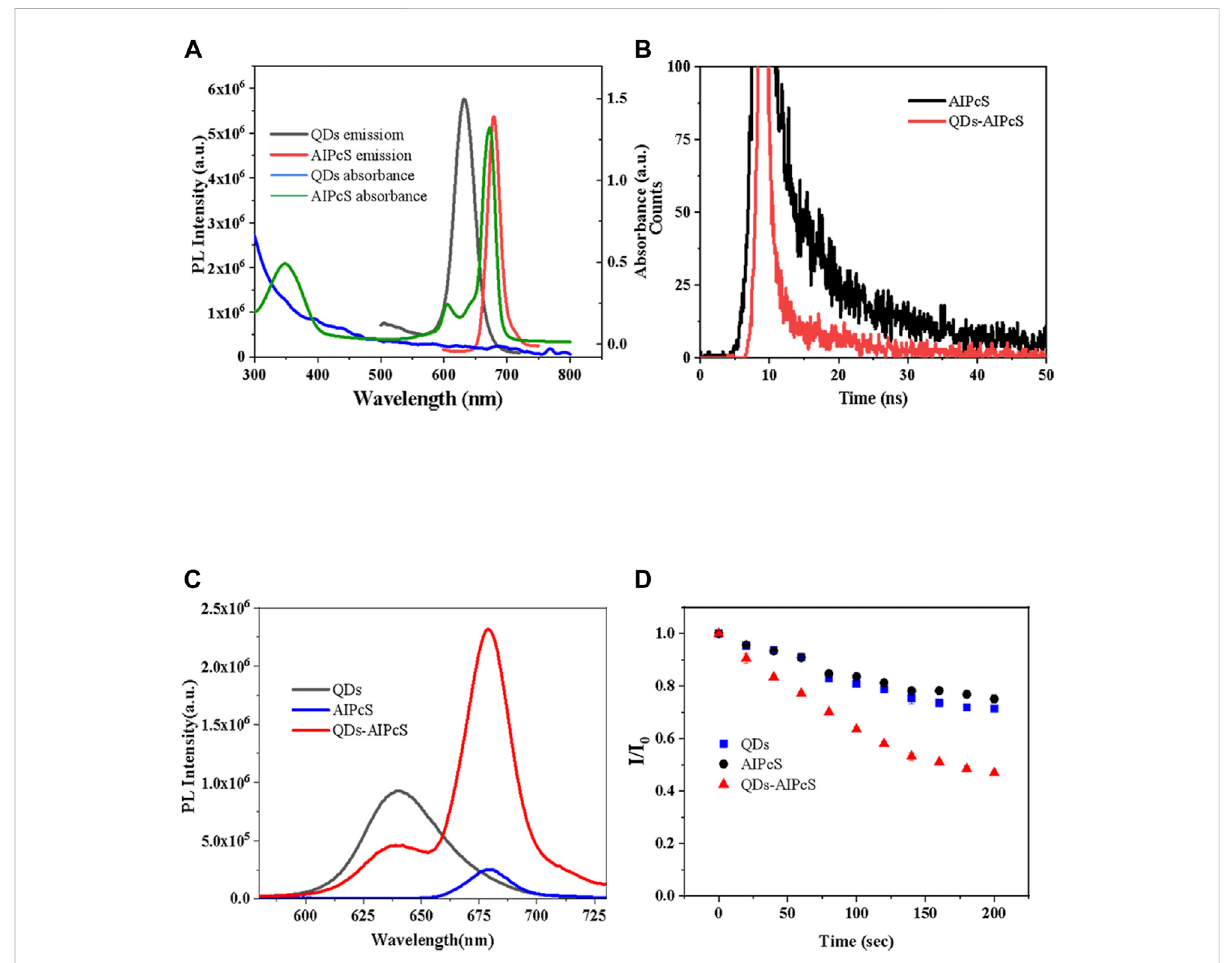
Photophysical properties of QDs, AlPcS, and QDs – AlPcS. (A) Absorption and emission spectrum of QDs and AlPcS. (B) PL life curves of QDs – AlPcS and free AlPcS excited by 400 nm light. (C) Fluorescence emission spectra of QDs – AlPcS, free QDs, and free AlPcS solution with excitation of 400 nm. (D) Comparison of DPBF photo-degradation in QDs – AlPcS, free QDs, and AlPcS